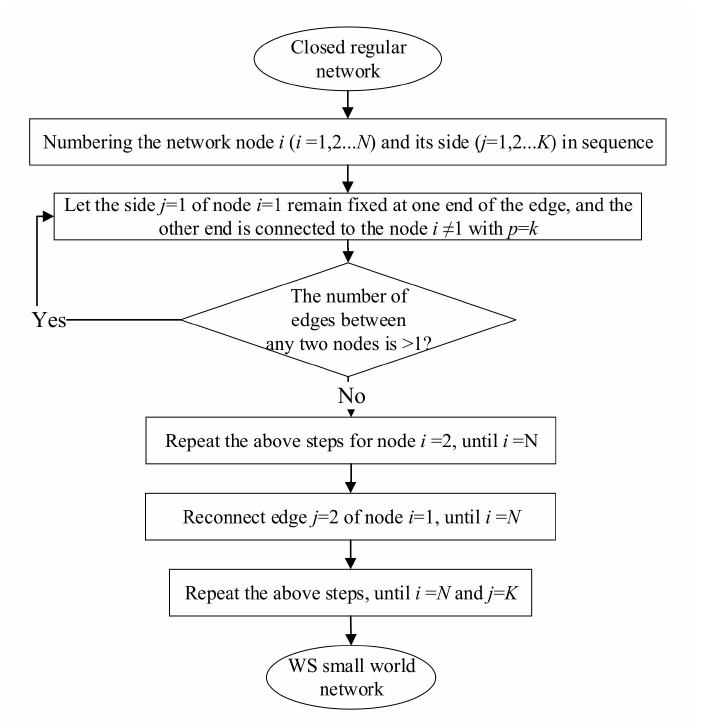
Figure 2. WS small-world network construction flow